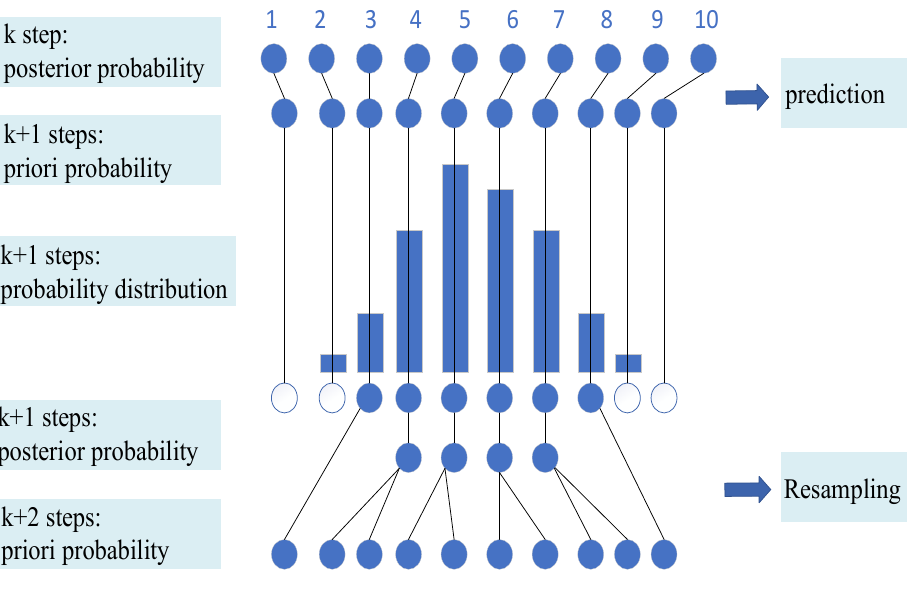
Figure 5. Flow chart of PF. Figure 6 shows the resampling schematic of Step k + 1 in the PF prediction method, where each solid origin represents a particle, and the hollow origin represents the rejected particle. The resampling process keeps the particles with higher probability and removes the particles with lower probability, thus updating the model of PF so that the model pa- rameters satisfy individual capacitors with individual differences. The Weibull distribution method and the Birnbaum–Saunders distribution method cannot accomplish this.